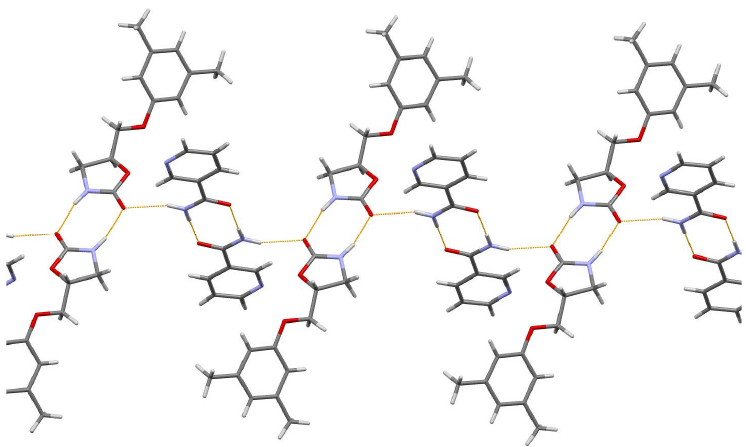
Figure 4. The hydrogen-bonded chain extended in [110] of imide and syn -amide homodimers of MET and NAM molecules, respectively, in MET-NAM 1:1 cocrystal. Thin orange lines denote inter- molecular N–H…O hydrogen